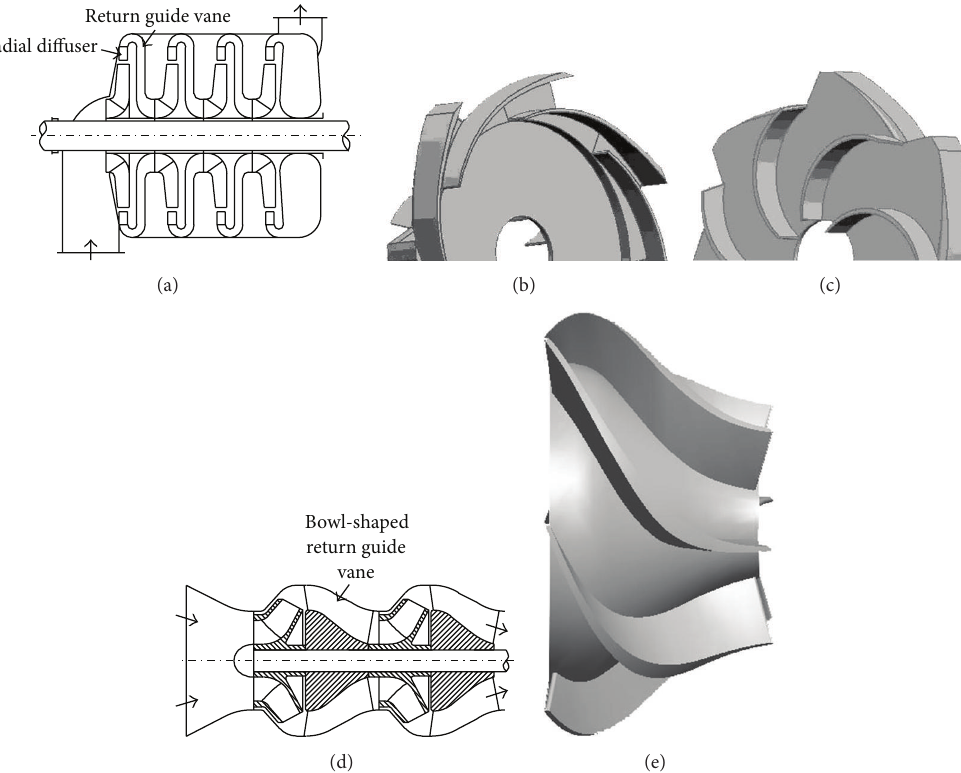
Figure 1: Two multistage pumps: (a) multistage pump equipped with radial diffuser and RGV, (b) radial diffuser, (c) RGV, (d) multistage pump equipped with bowl-shaped RGV, and (e) bowl-shaped RGV.